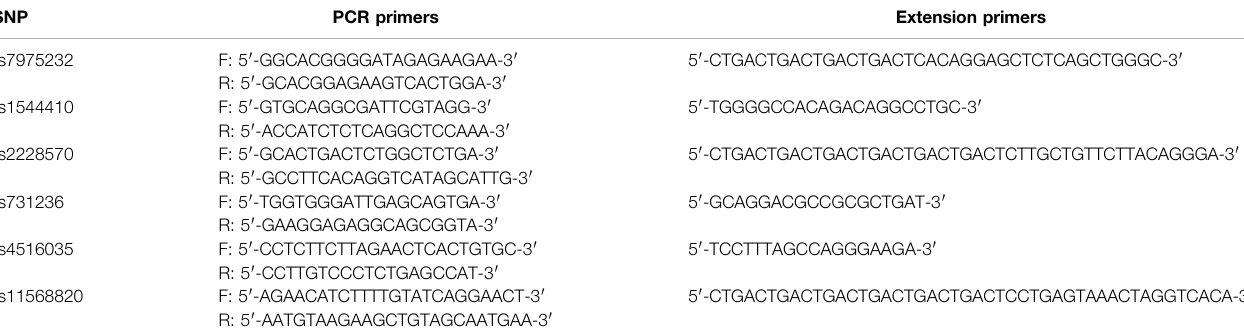
TABLE 1 | PCR primers and extension primers of the six VDR genetic